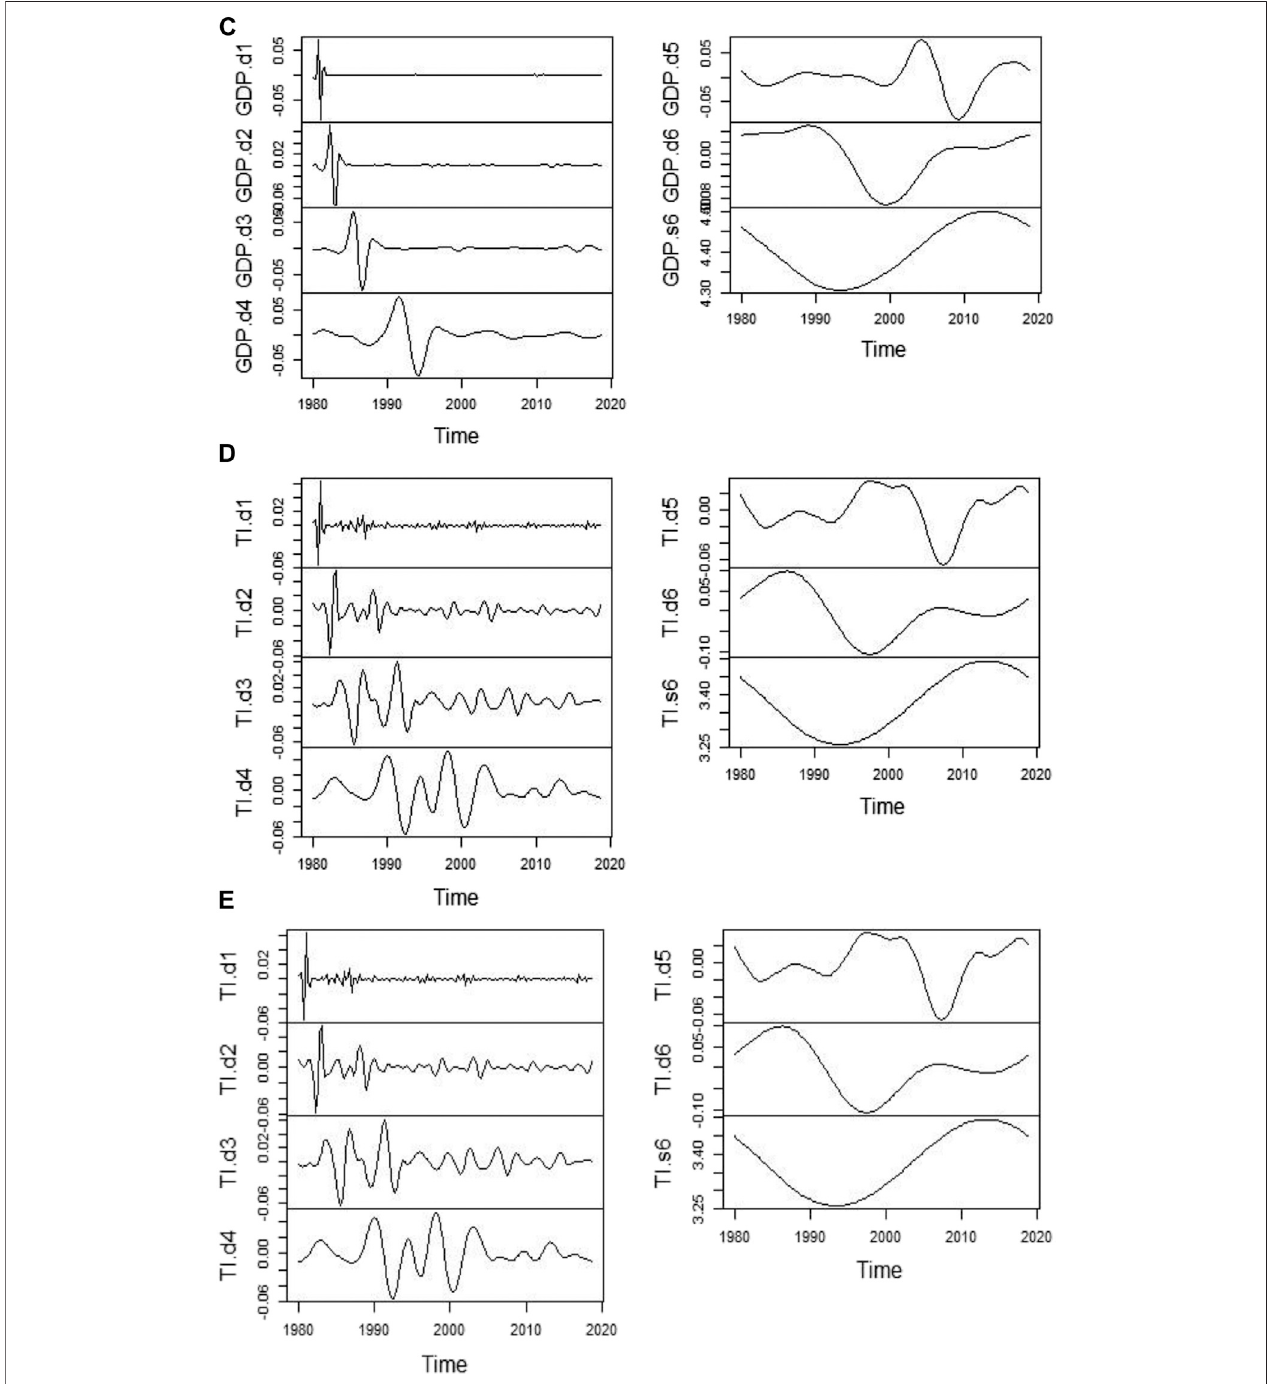
FIGURE 4 | (A) REN wavelet trans fi guration. (B) CO 2 wavelet trans fi guration. (C) GDP wavelet trans fi guration. (D) GLO wavelet trans fi guration. (E) TI wavelet trans fi